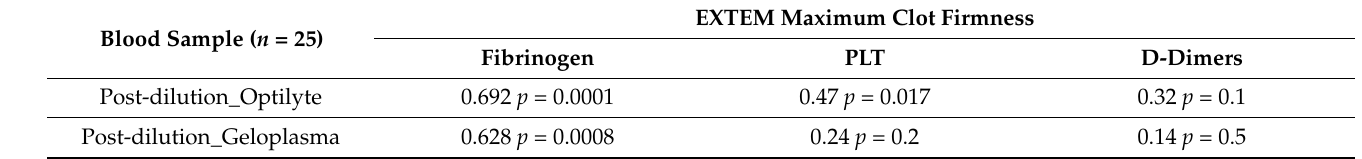
Table 5. Correlations between the EXTEM and INTEM maximum clot firmness and standard